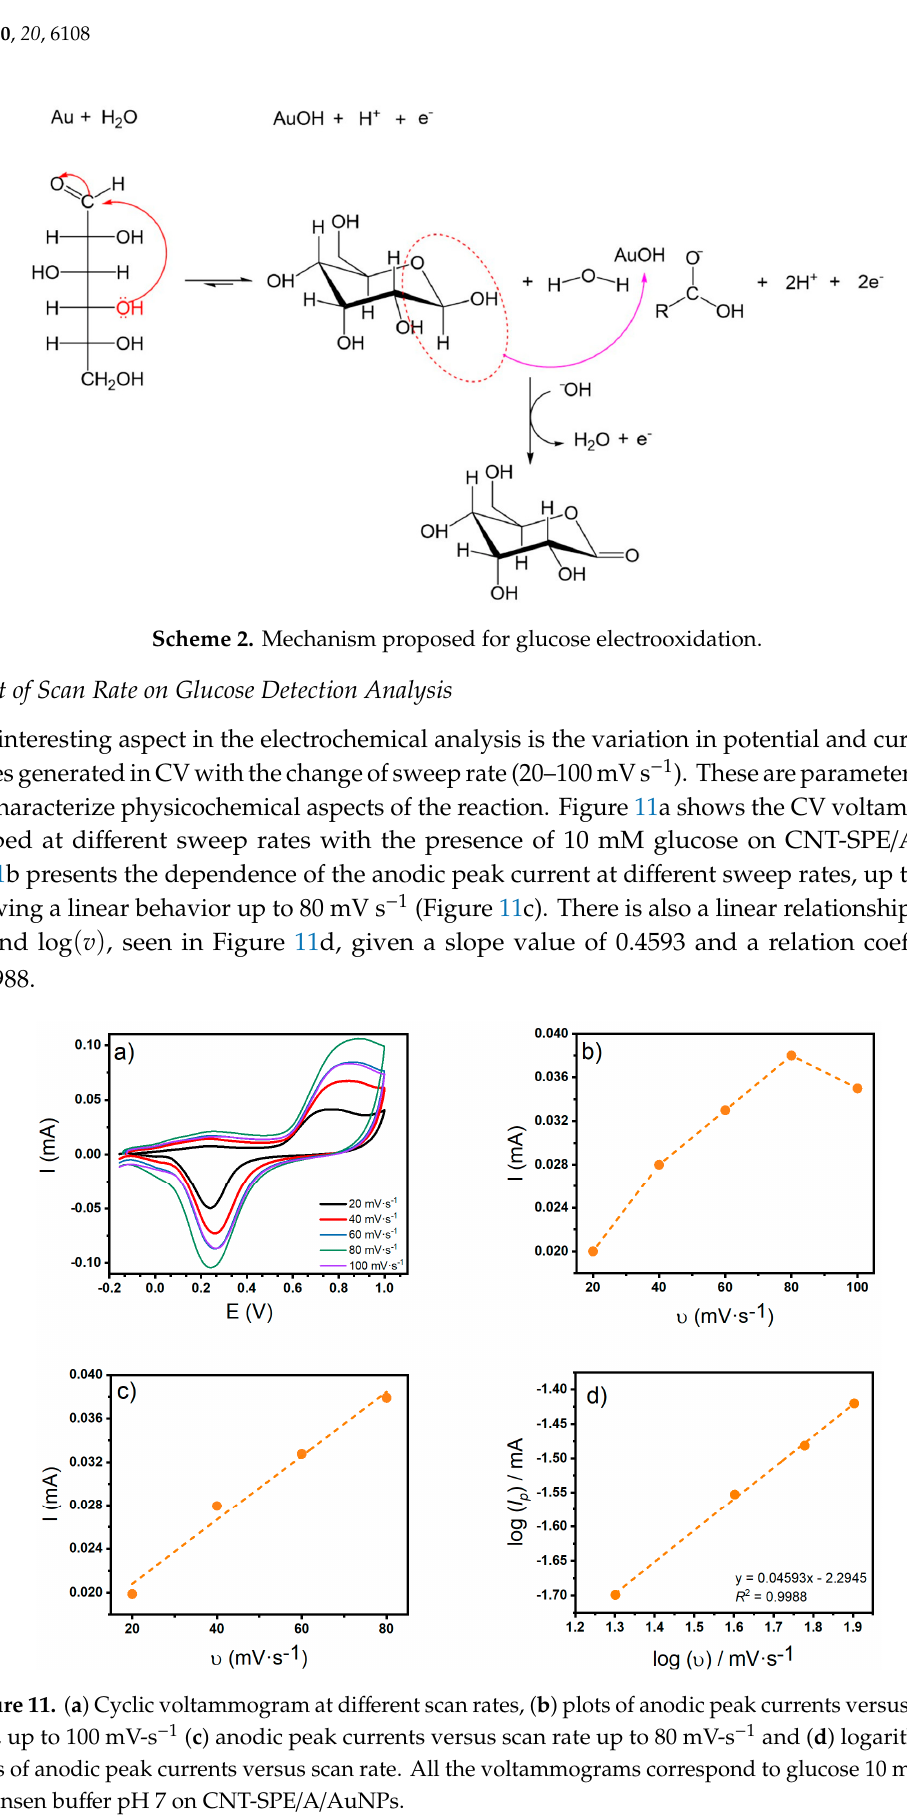
Figure 12. Linear regression to anodic potential against logarithmic sweep rate of glucose 10 mM on CNT-SPE/A/AuNPs in Sorensen buffer pH 7.